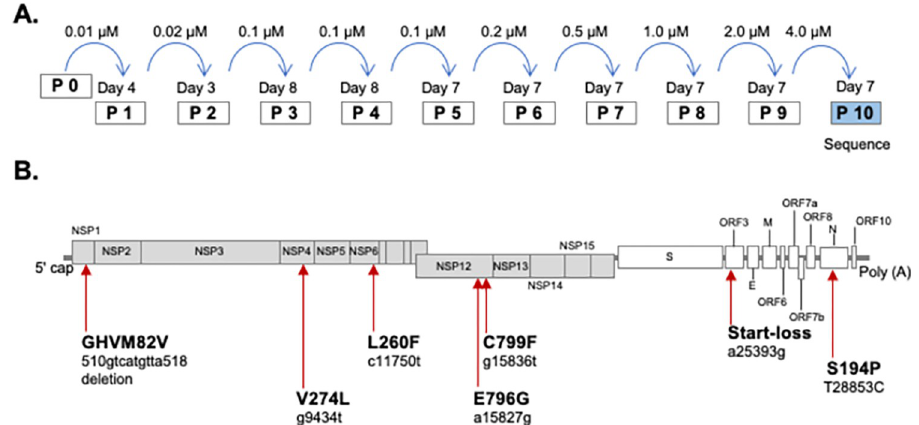
Fig 1. Identification of RDV-resistant mutations of SARS-CoV-2. (A) Schematic image of the in vitro serial passage of SARS-CoV-2 in the presence of RDV. Supernatants of virus-infected cells were passaged with gradually increased concentrations of RDV. The virus sequence was examined after 10 passages. (B) The SARS-CoV-2 genome with the locations of mutations, which demonstrated more than 80% of frequency in Miseq sequence and more than 90% of frequency in single virus sequence after 10-time passages of SARS-CoV-2 with